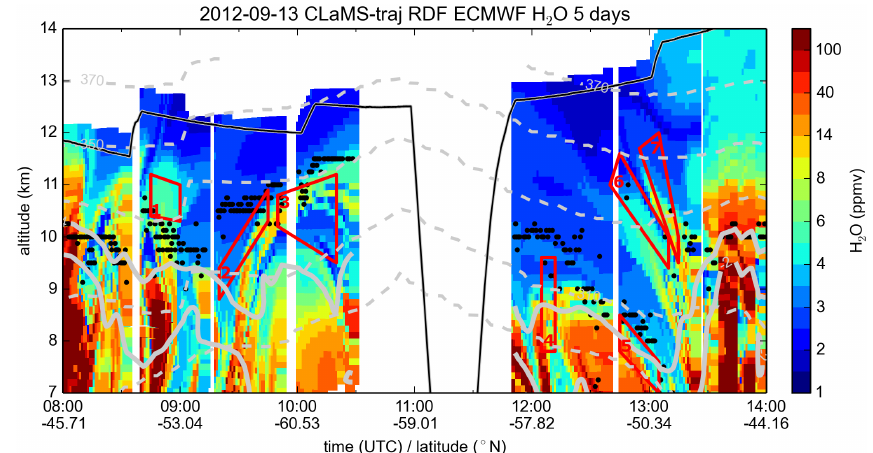
Figure 7. RDF (reverse domain filling) of each GLORIA tangent point trajectory with ECMWF water vapor of 5 days prior to the measure- ment time. Red boxes show the location of the observed filaments. The flight path, tropopause height, potential temperature, and PV isolines are the same as in Fig. 4.